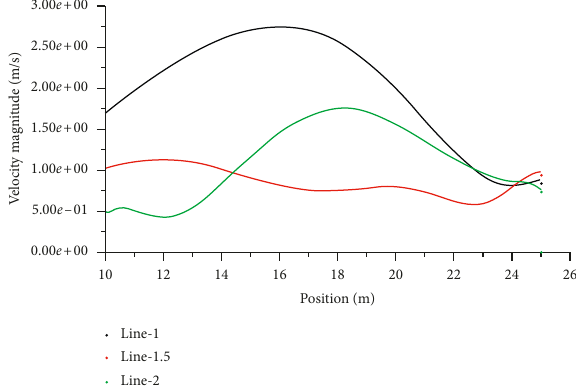
Figure 9: Wind speed at three heights in the